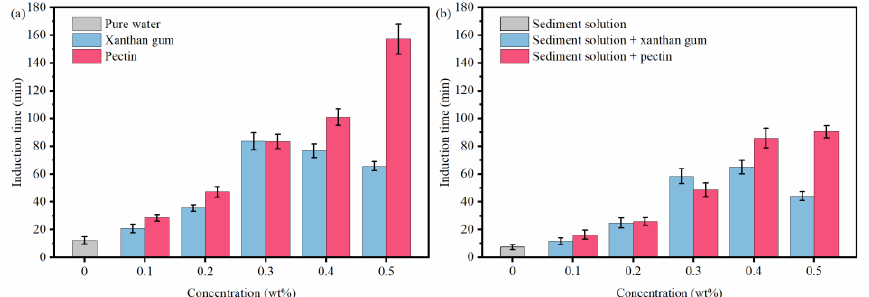
Figure 4. Effects of xanthan gum and pectin on the induction time of hydrate formation: ( a ) pure water systems; ( b ) sediment solution systems.